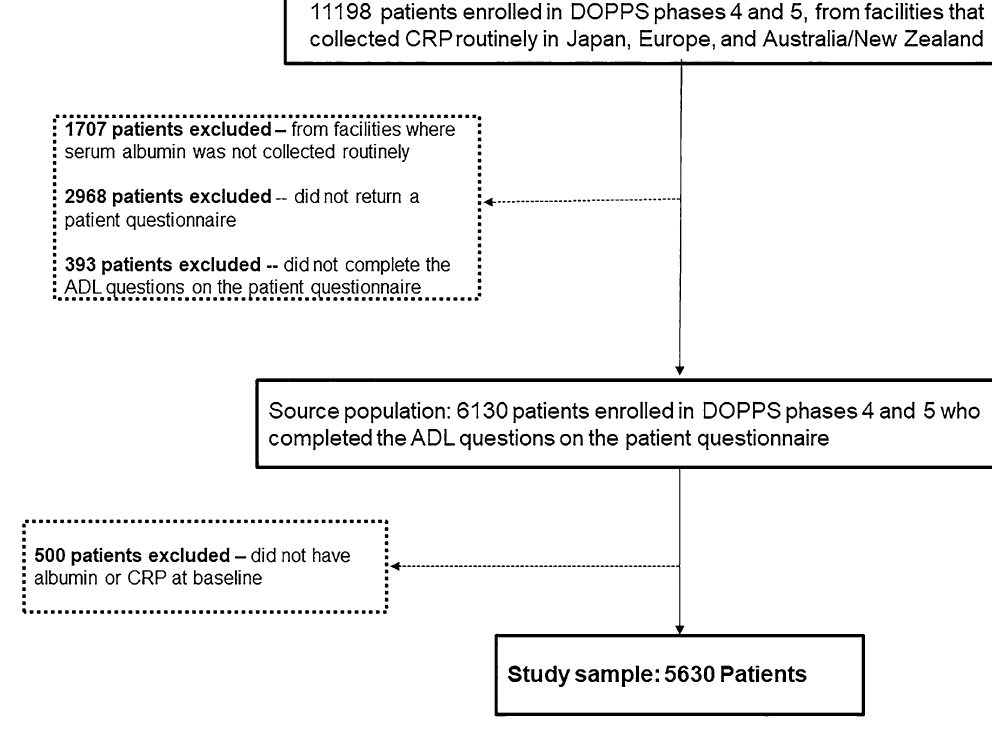
Figure 1. STROBE diagram of the study sample. ADL, activities of daily living; CRP, C-reactive protein.